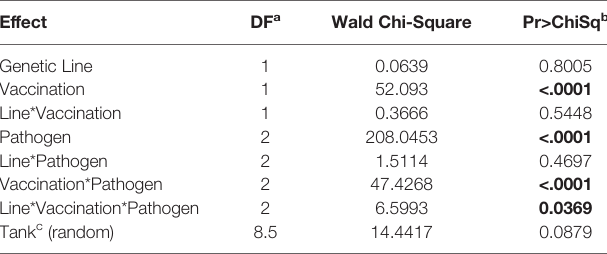
TABLE 5 | Signi fi cant effects survival analysis in the laboratory